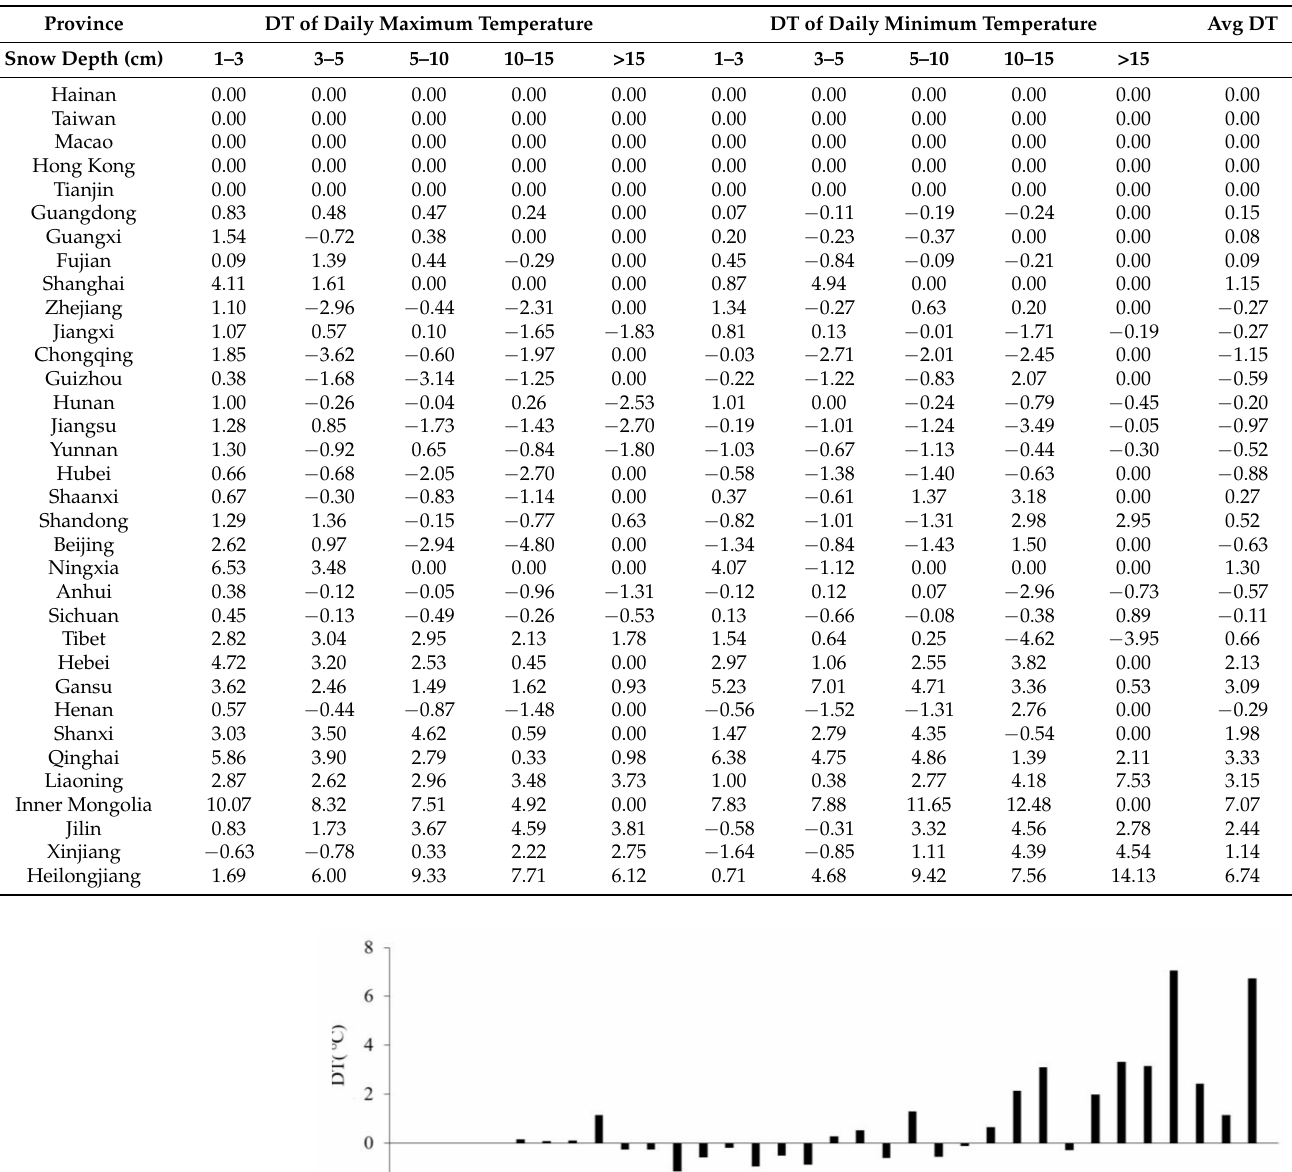
Table 4. Difference in temperature (DT) between the GFDL-ESM2G model and meteorological station observations for each province under different snow depth conditions.